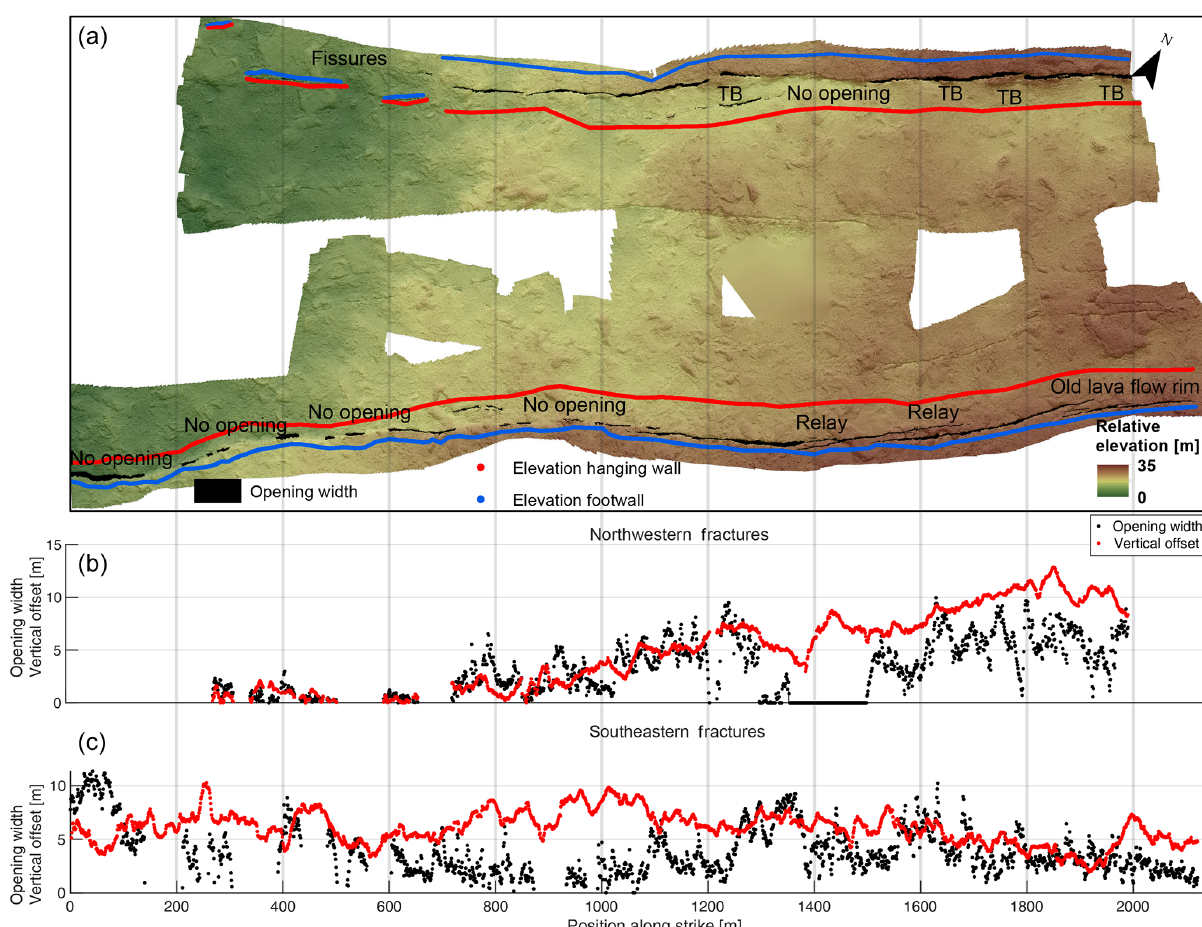
Figure 11. Fractures of the Vogar fissure swarm. (a) DEM with the mapped opening width of the fractures and elevation extraction points. The elevation extraction points of the fissures in the NW are not shown due to the scale. (b) Opening width (black) and vertical offset (red) plotted along strike of the northern fracture. (c) Opening width (black) and vertical offset (red) plotted along strike of the southern fracture. The x -axis scale of both plots is analogous to the scale in the DEM in panel (a) ; 63 ◦ 58 (cid:48) 0 (cid:48)(cid:48) N, 22 ◦ 20 (cid:48) 40 (cid:48)(cid:48) W. Projection of the DEM: WGS1984 UTM